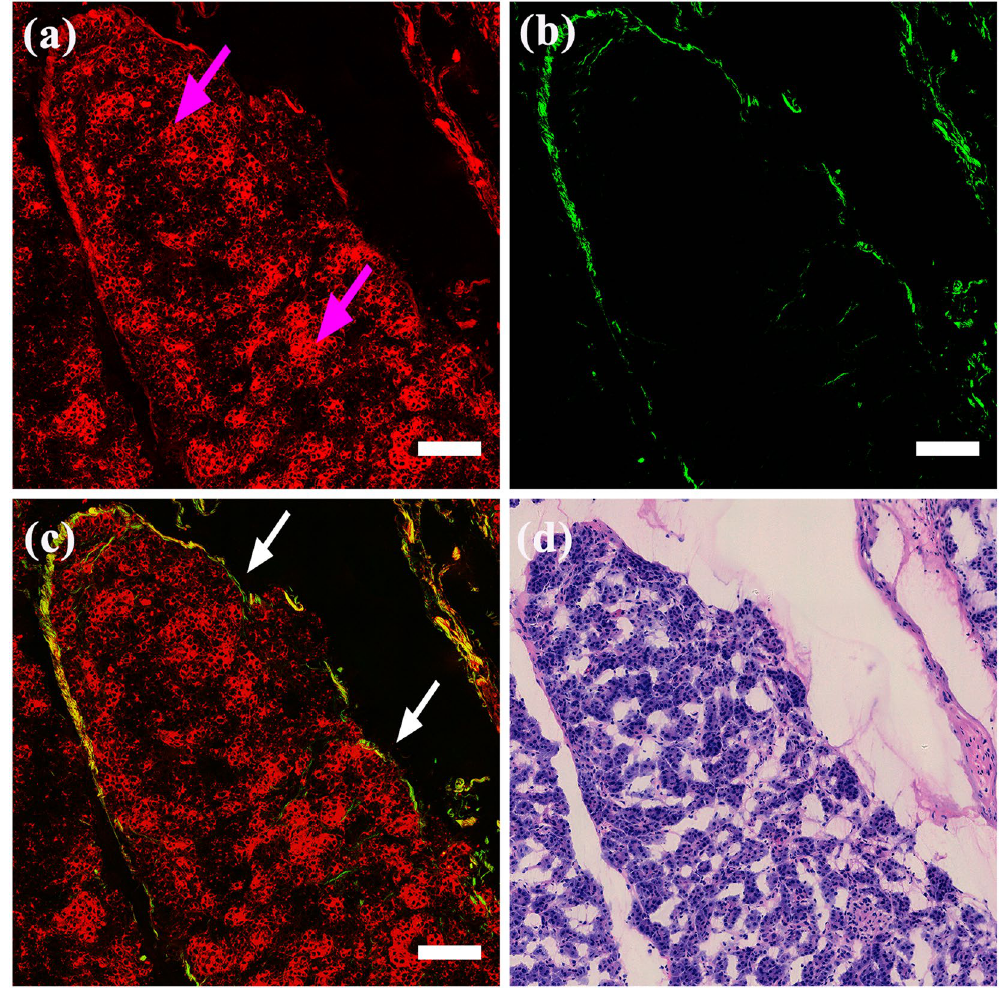
Figure 2. MPM images and the corresponding H&E-stained images of a normal pancreatic lobule. Magnification of H&E-stained image is 40 × ; Scale: 100 μ m. ( a ) TPEF image; ( b ) SHG image; ( c ) Overlay of TPEF and SHG image; ( d ) H&E-stained image. White arrows: pancreatic lobule; pink arrows: pancreatic acinar